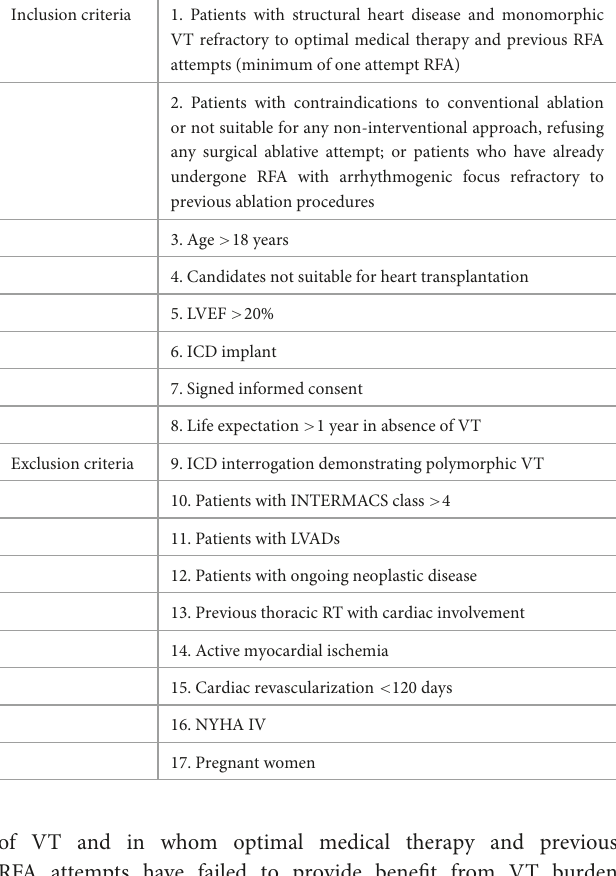
TABLE 1 Inclusion and exclusion criteria. Inclusion